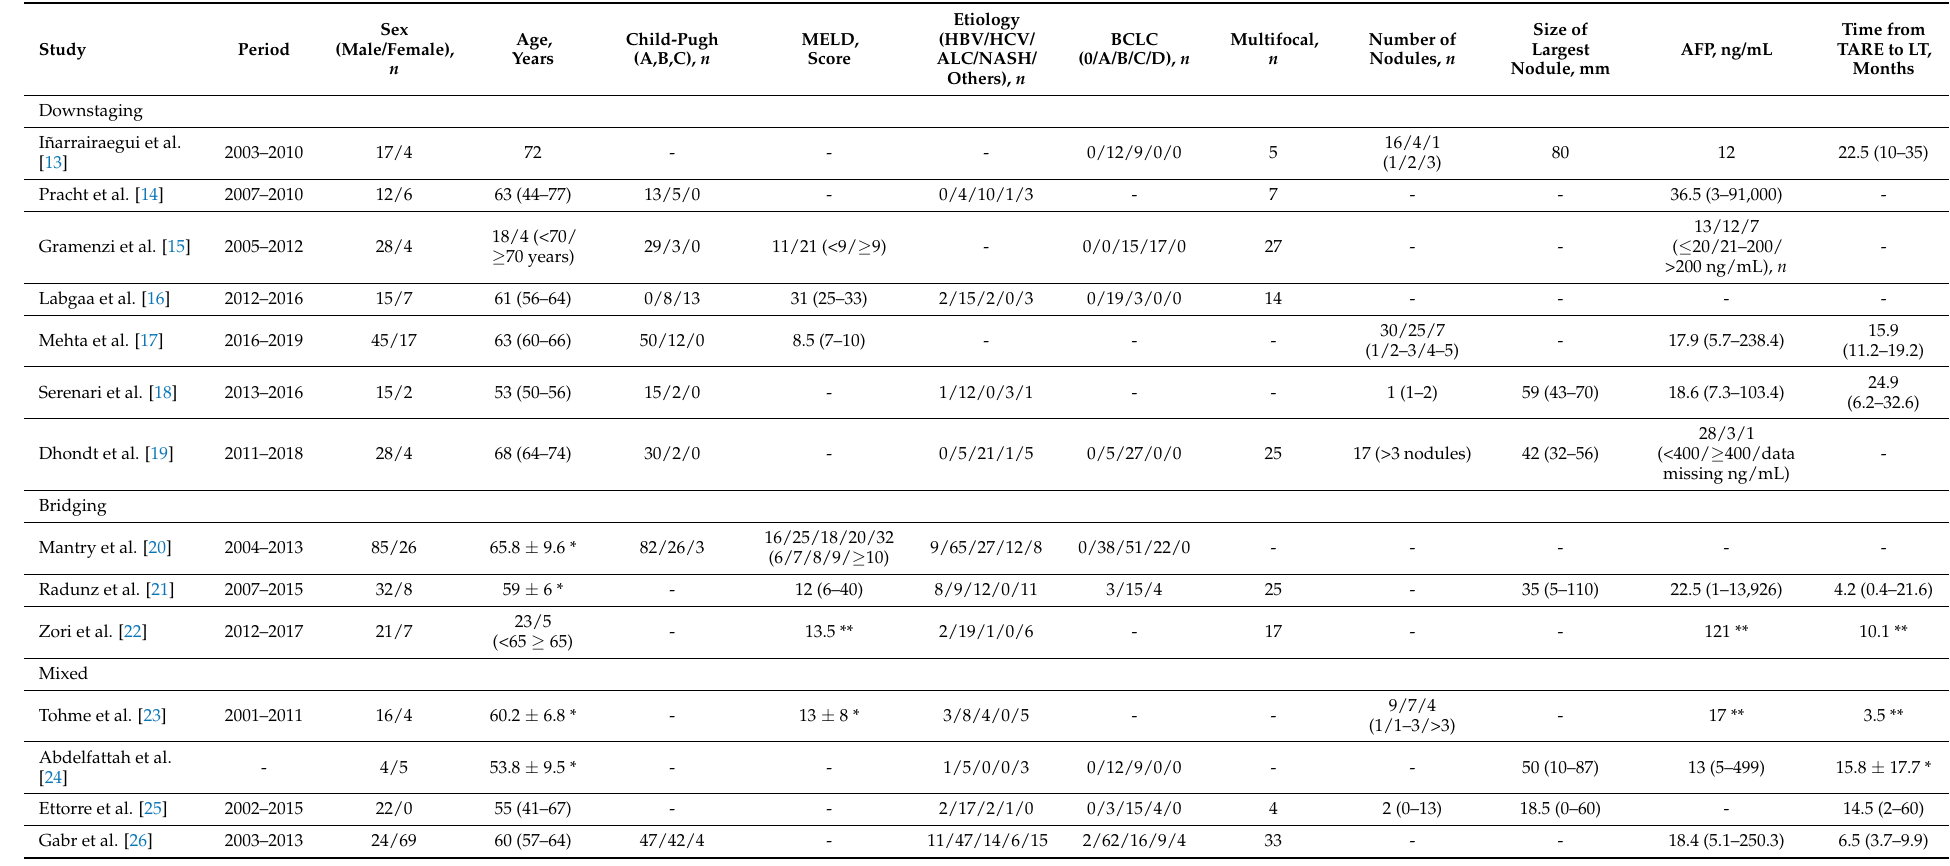
Values are expressed as median (range), or number ( n ) as indicated. * Values with means ± SD (standard deviation). ** Values with means. TARE: transarterial radioembolization, LT: liver transplant, MELD: Model for End-stage Liver Disease, HBV: hepatitis B virus, HCV: hepatitis C virus, Alch: alcoholic, NASH: nonalcoholic steatohepatitis, BCLC: Barcelona Clinic Liver Cancer staging system, AFP: